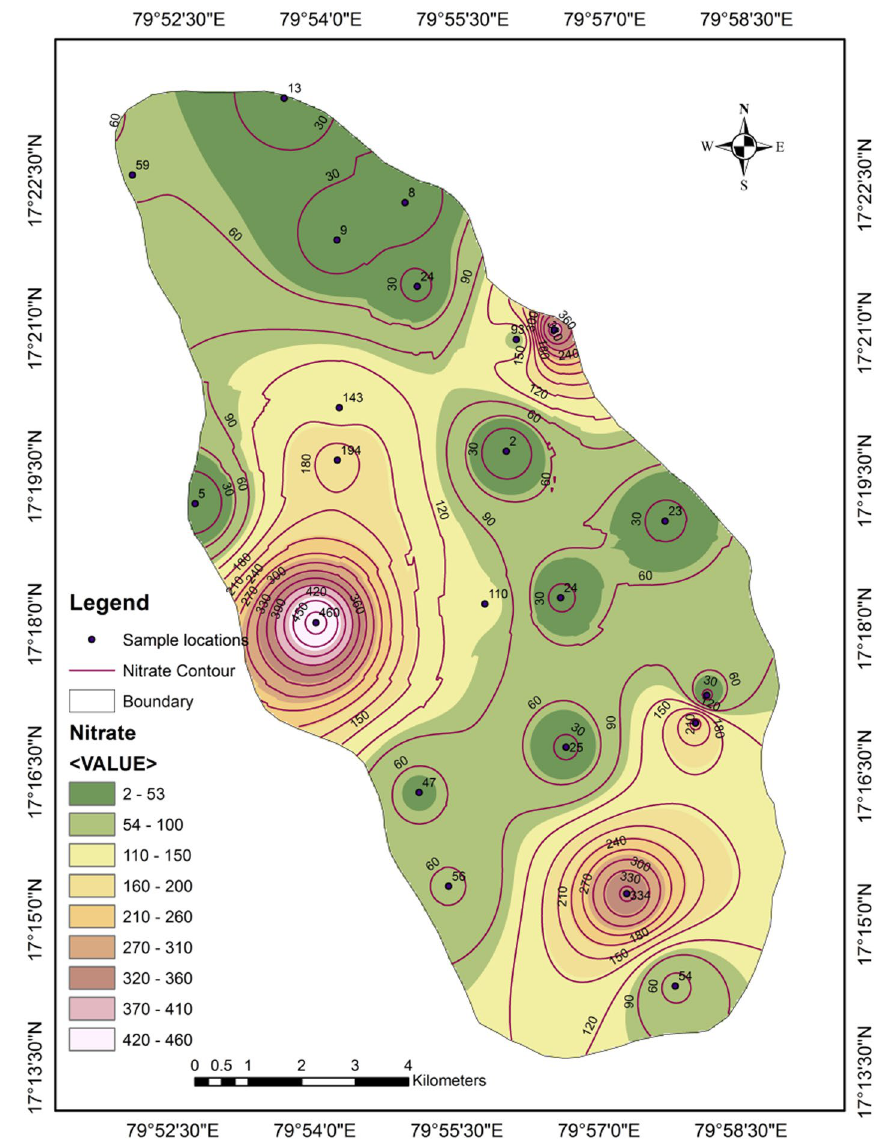
Fig. 8 Nitrate distribution in the Subledu Basin